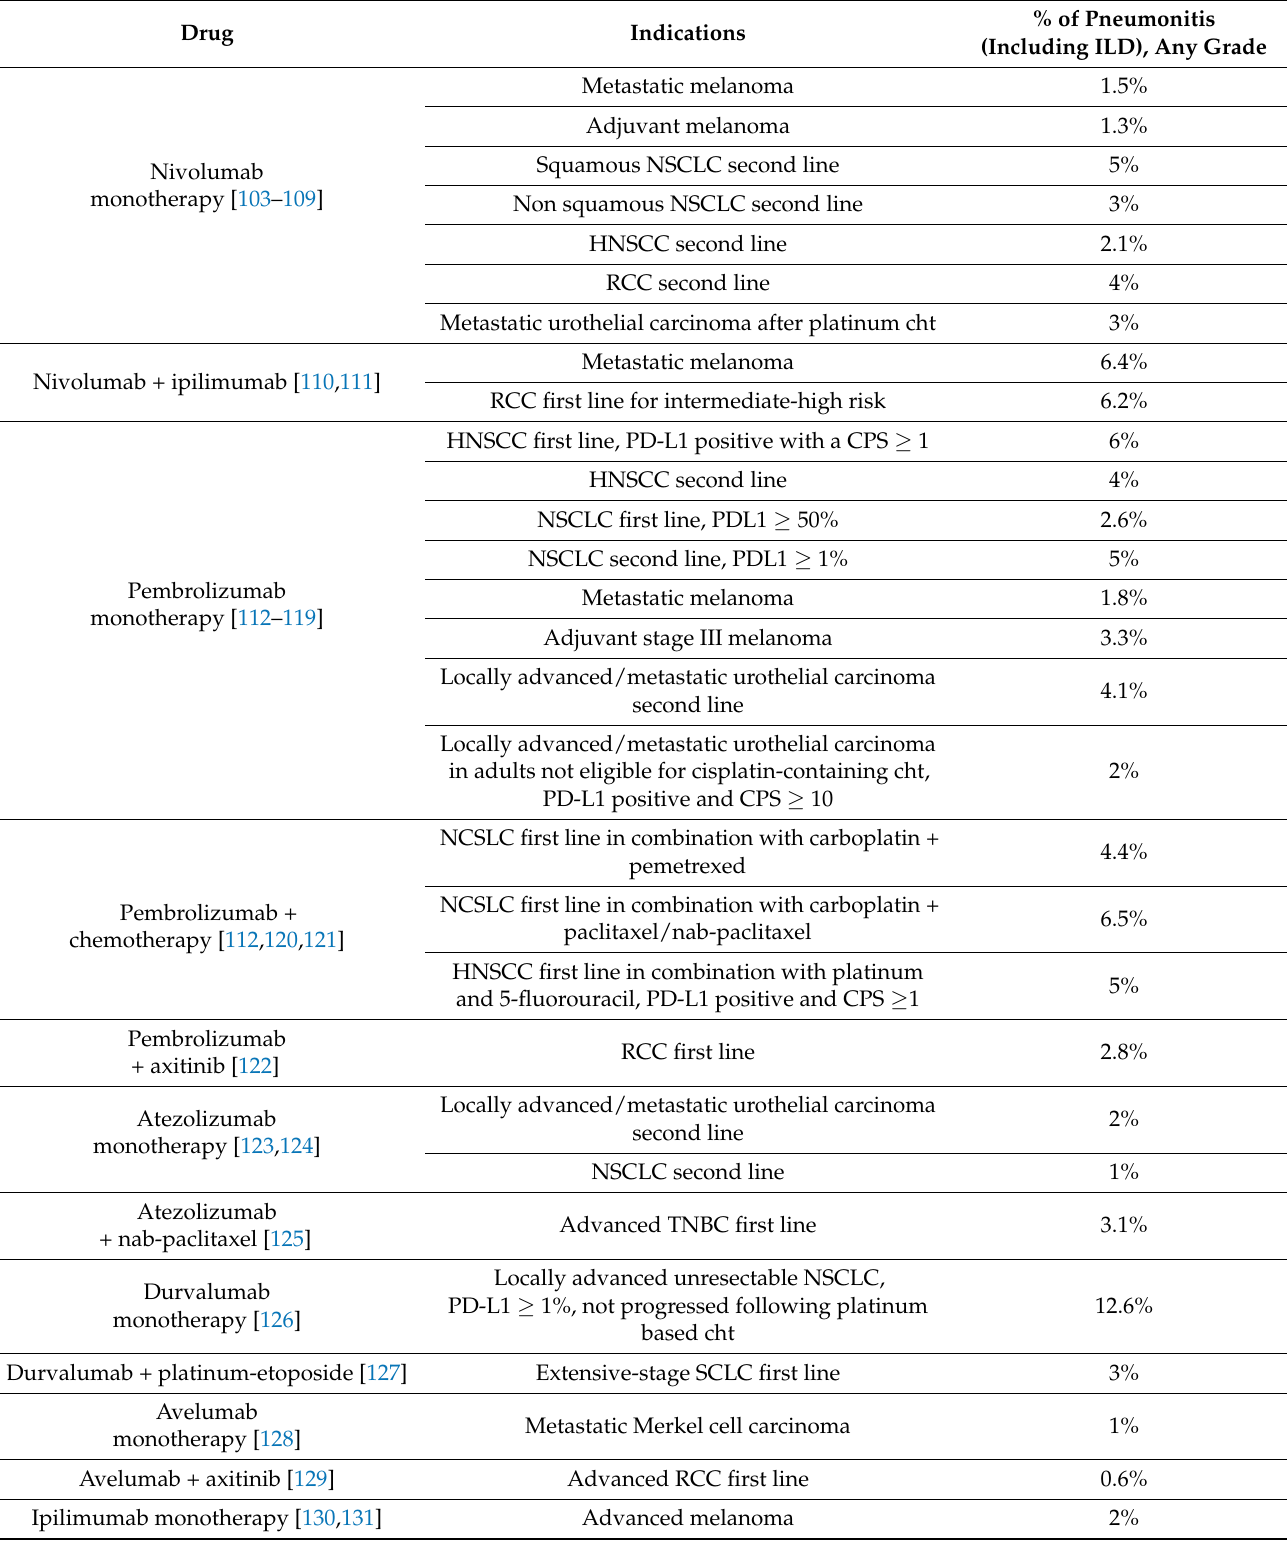
Table 3. Incidence of pneumonitis with immune checkpoint inhibitors approved by the FDA and EMA in the treatment of solid